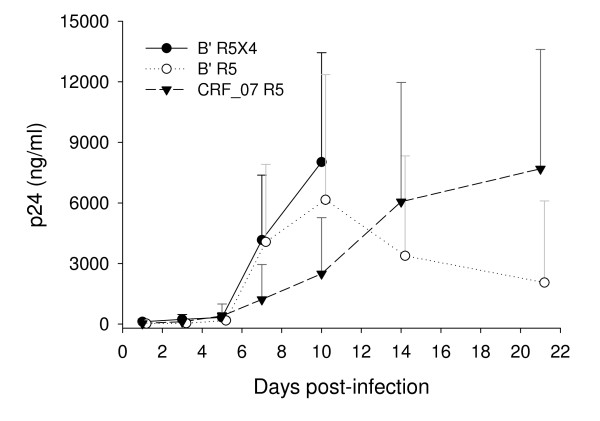
Comparison of the replication kinetics of the CRF07_BC R5 virus with that of the subtype B' R5 and R5/X4 viruses. The viral replication was determined by ELISA for p24 production. Each sample was tested in duplicate using the PBMCs from the same healthy blood donor. The experiment was repeated using the PBMCs from another healthy blood donor. The data are presented in mean ± SD.